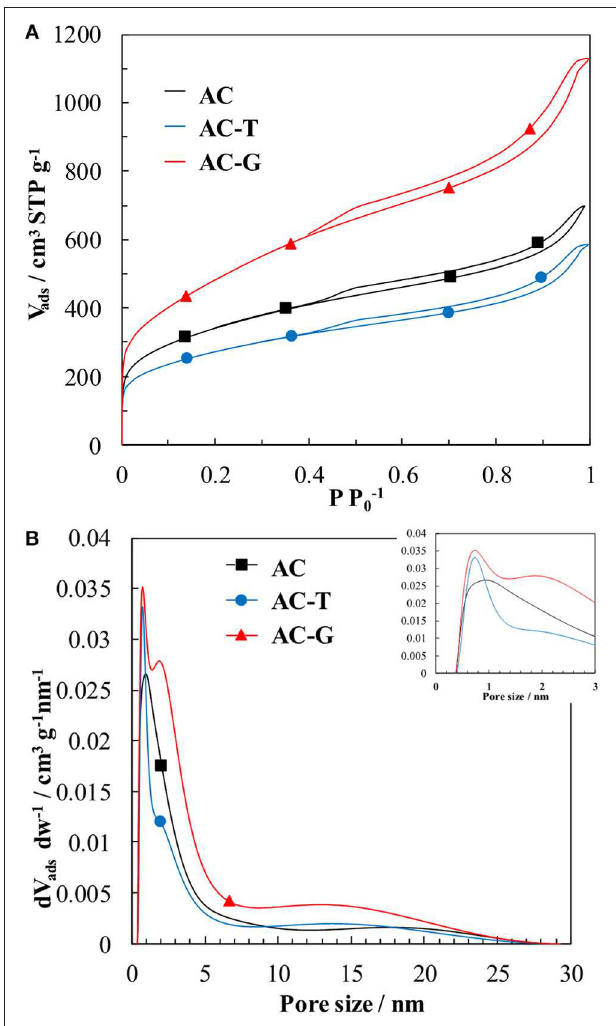
FIGURE 1 | (A) N 2 adsorption-desorption isotherms at − 196 ◦ C of AC (square dot), AC-T (circle dot), and AC-G (triangle dot). (B) NL-DFT pore size distribution (PSD) derived from the N 2 adsorption isotherms.